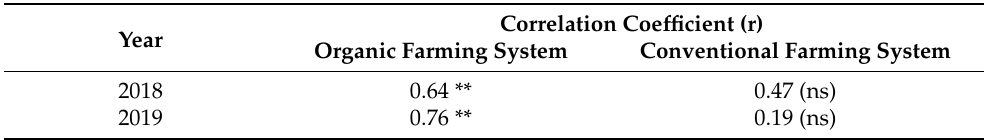
Table 2. Correlation between yield of buckwheat biomass dry matter (t ha − 1 ) and grain yield (t ha − 1 ) ( n = 15).